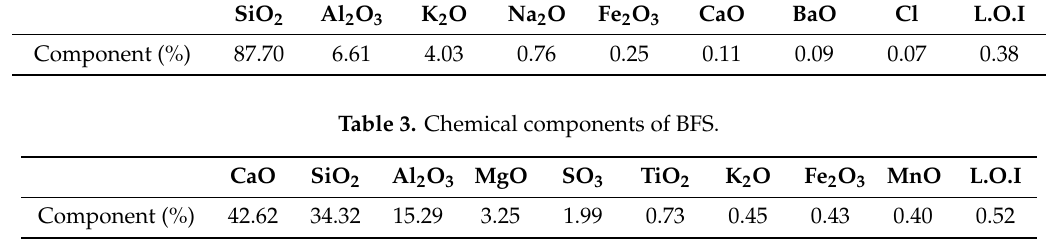
Table 3. Chemical components of BFS.